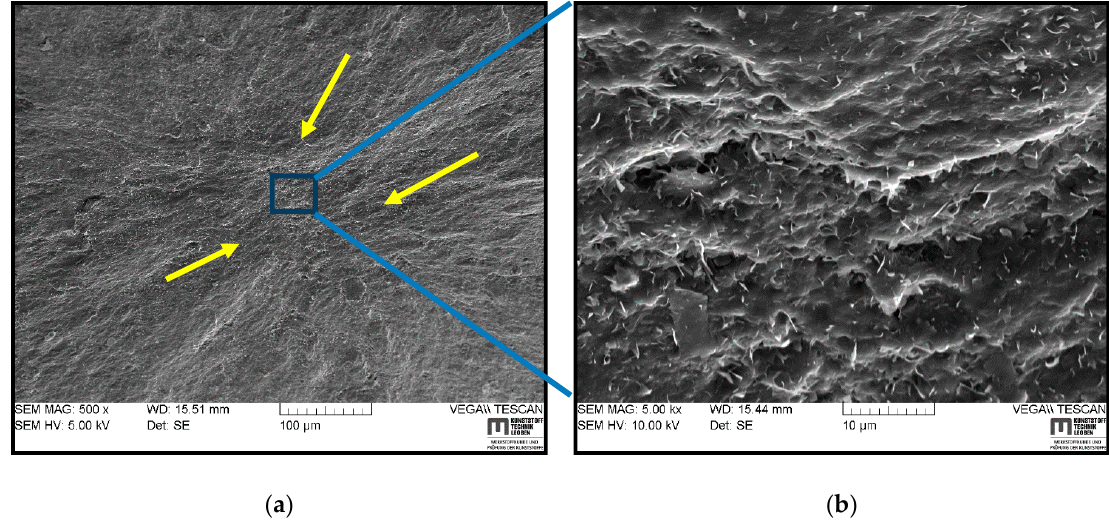
Figure 6. SEM images of a typical fracture surface of HNBR1 in different magnifications: ( a ) fracture initiation and propagation; ( b ) magnified view of fracture initiation.